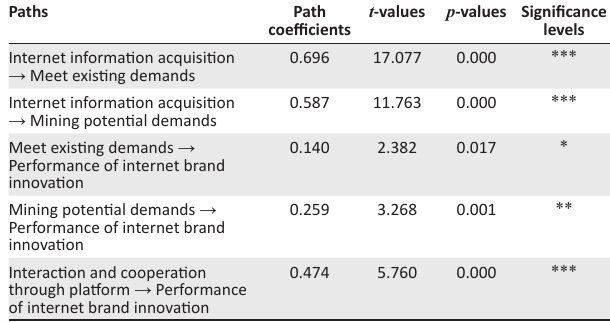
TABLE 5: Significance testing results of structural model path coefficients.